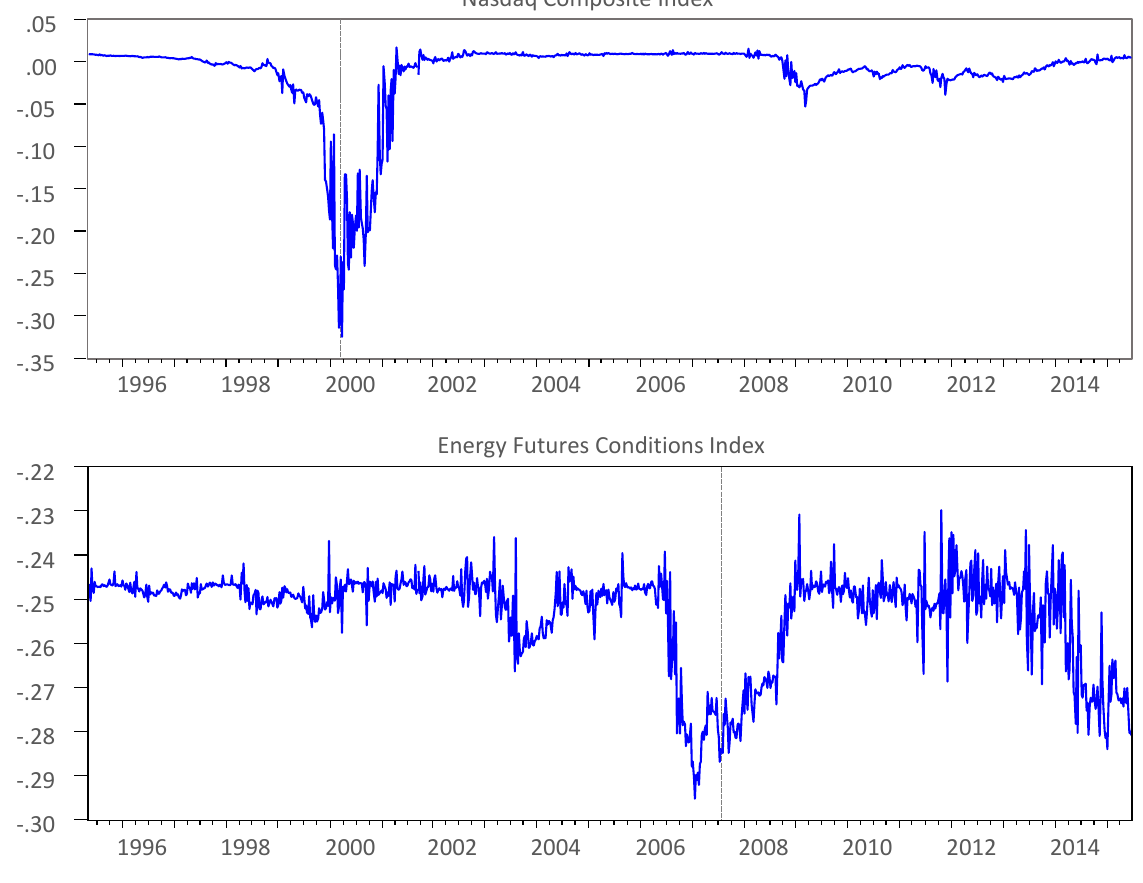
Figure 5. Dickey-Fuller autoregressive